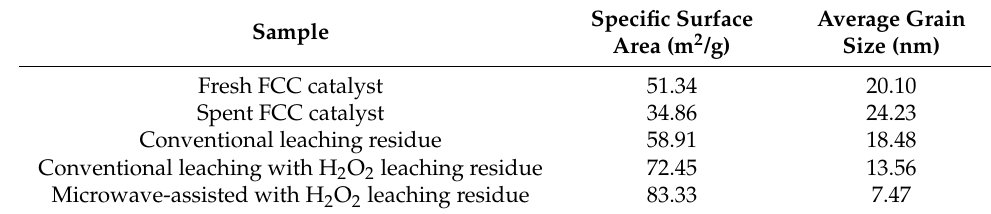
Table 6. Pore structure parameters of SFCC catalysts before and after acid leaching.